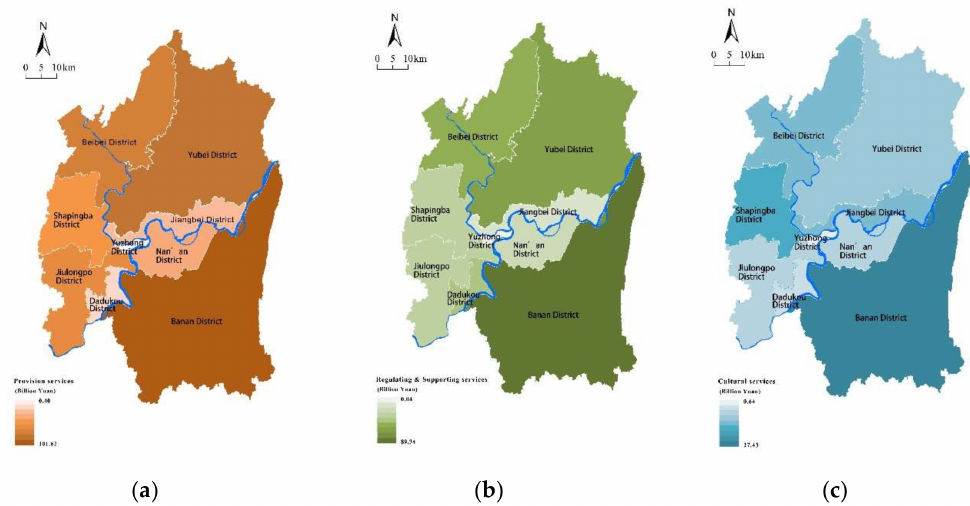
Figure 4. ( a ) Spatial distribution of provision services. ( b ) Spatial distribution of regulating and supporting services. ( c ) Scheme 5. Spatial distribution of ESs supply.